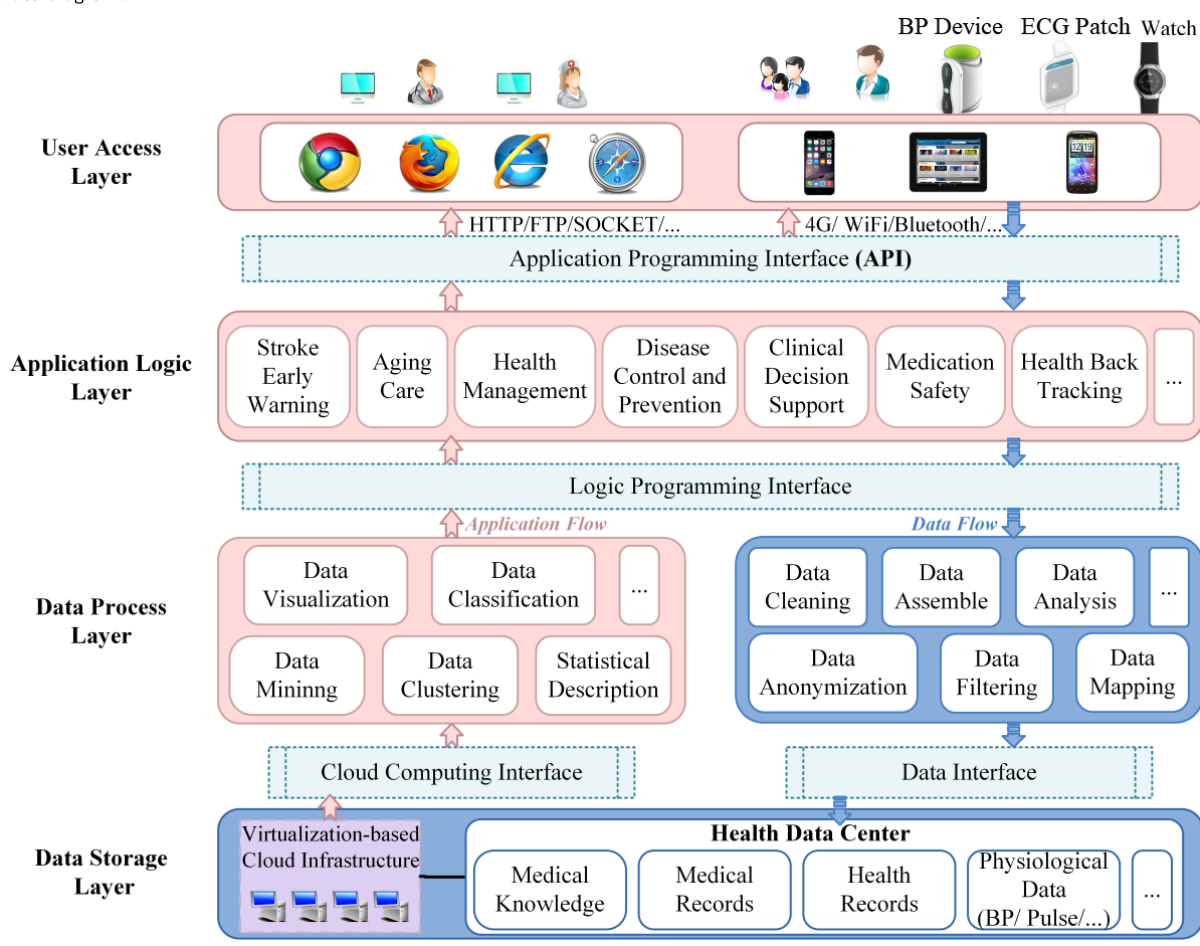
Figure 1. The four-layer ambulatory blood pressure monitor mobile health architecture for stroke-risk early warning. BP: blood pressure; ECG: electrocardiogram.